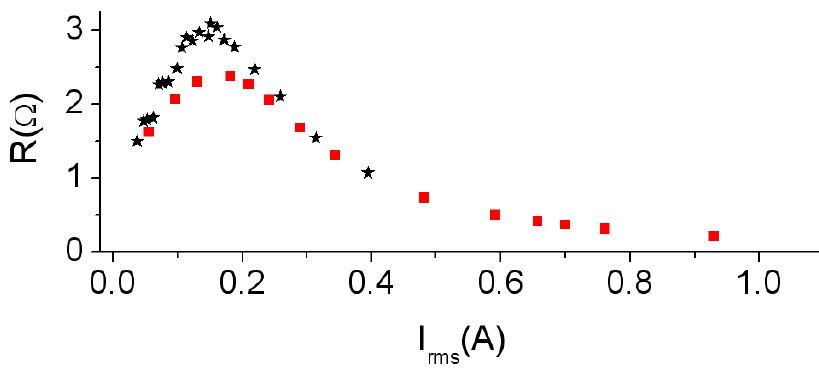
curve. Experiment (– *–) and 2D simulation ( – ■ – rms